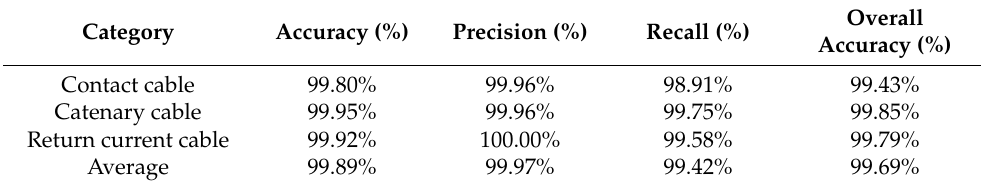
Table 4. Accuracy evaluation index of classification results of the 100 m OCS point